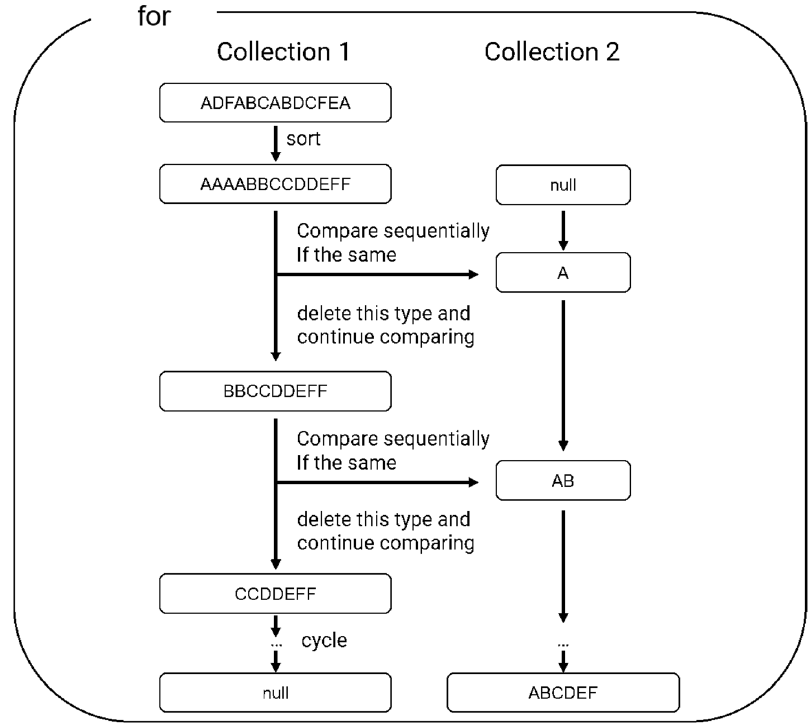
Figure 3. Screening calculation process.